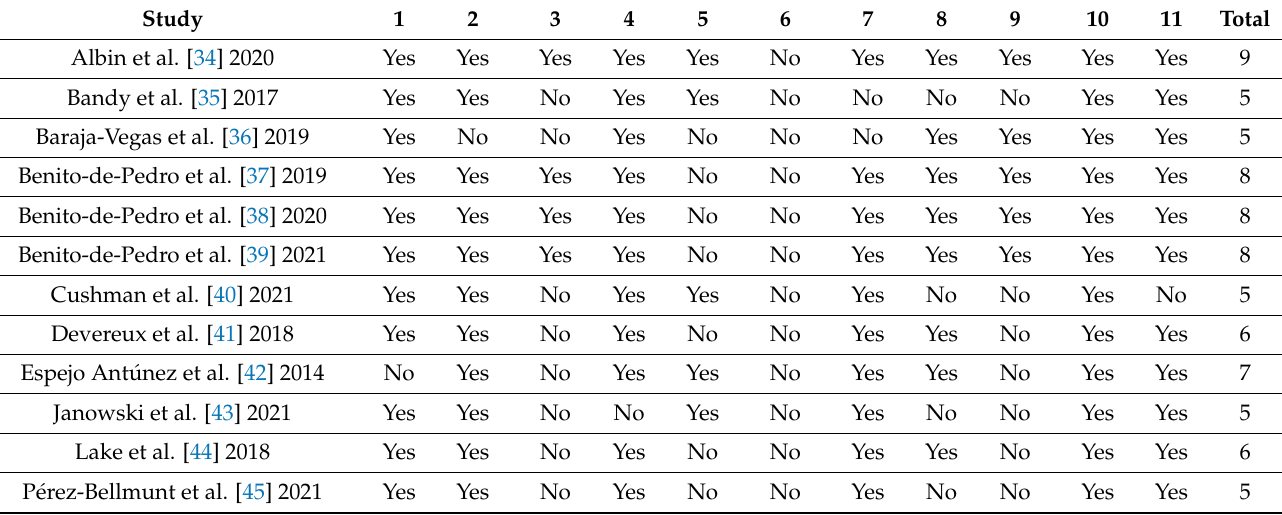
Table 2. Physiotherapy Evidence Database scores for clinical trials included in the review.